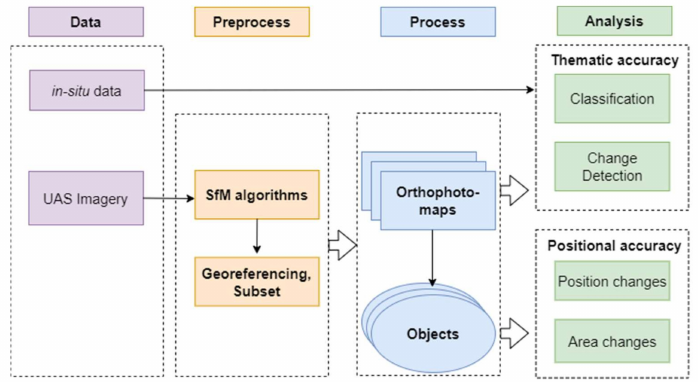
Figure 2. Workflow of the